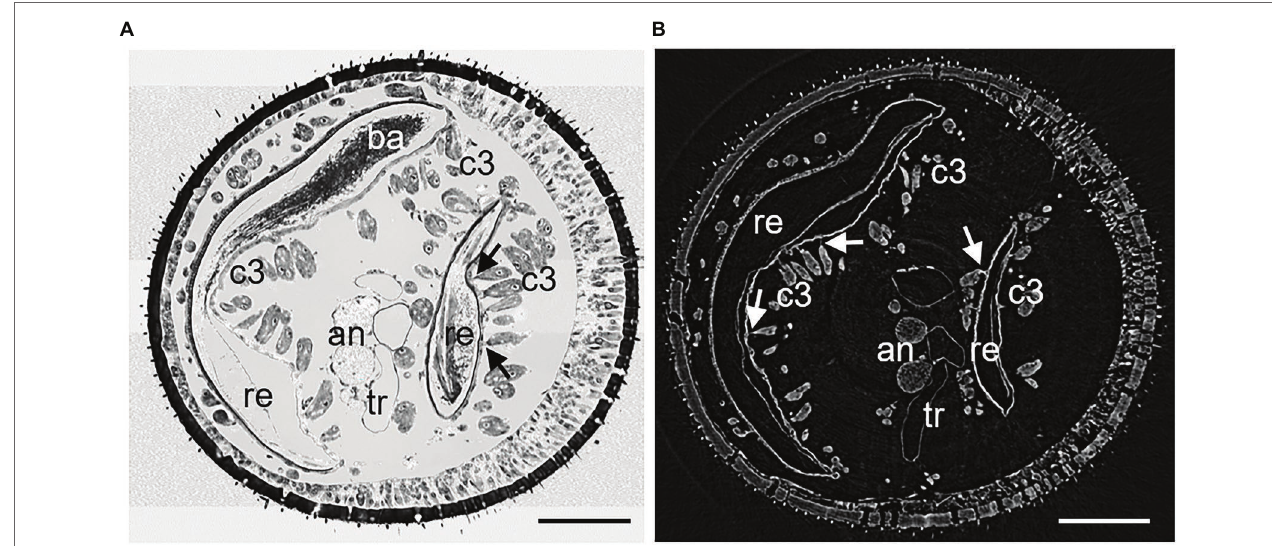
FIGURE 2 | Cross sections of similar areas of antennomeres A6 of female Philanthus triangulum : (A) Semithin section and (B) μ CT image. The larger part of the reservoir is on the left, the smaller lobe on the right. The cuticle on the left of each reservoir part is thickened and reticulated. Canals of the class III gland cell units are readily visible also in the μ CT image. Due to critical-point drying, cells and tissues in (B) may have shrunk. an, antennal nerve; ba, bacteria; c3, class 3 gland cells; re, reservoir; tr, tracheole; and arrows – conducting canals between acini and reservoir. Scale bars 100 μ